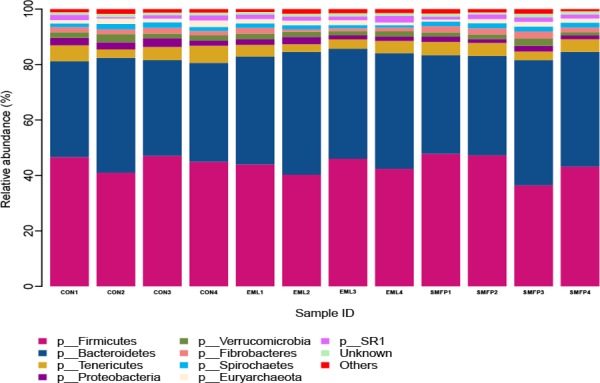
Phylum level composition.Stacked bar plot showing the phylum-level composition for individual steer rumen sample. CON: control group (n = 4); EML: ensiled mulberry leaves group (n = 4); SMFP: sun-dried mulberry fruit pomace group (n = 4).